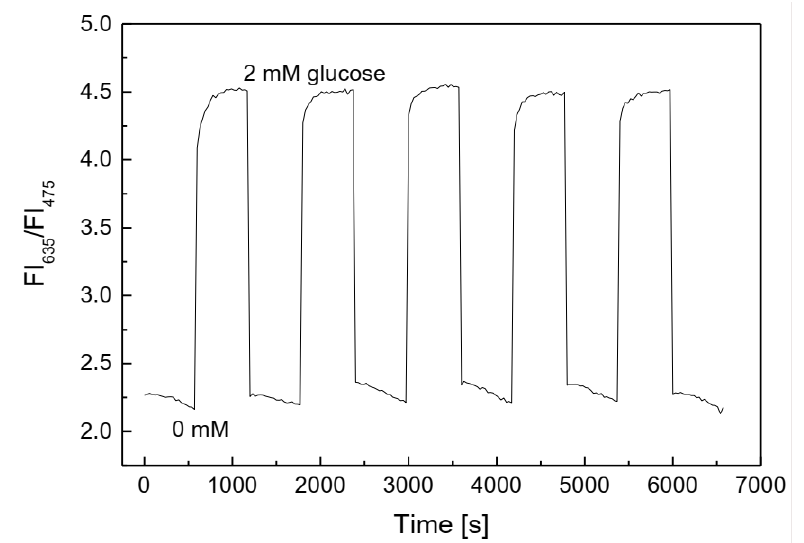
Figure 5. Reversibility of the glucose-sensing membrane repeatedly exposed at 0 and 2 mM